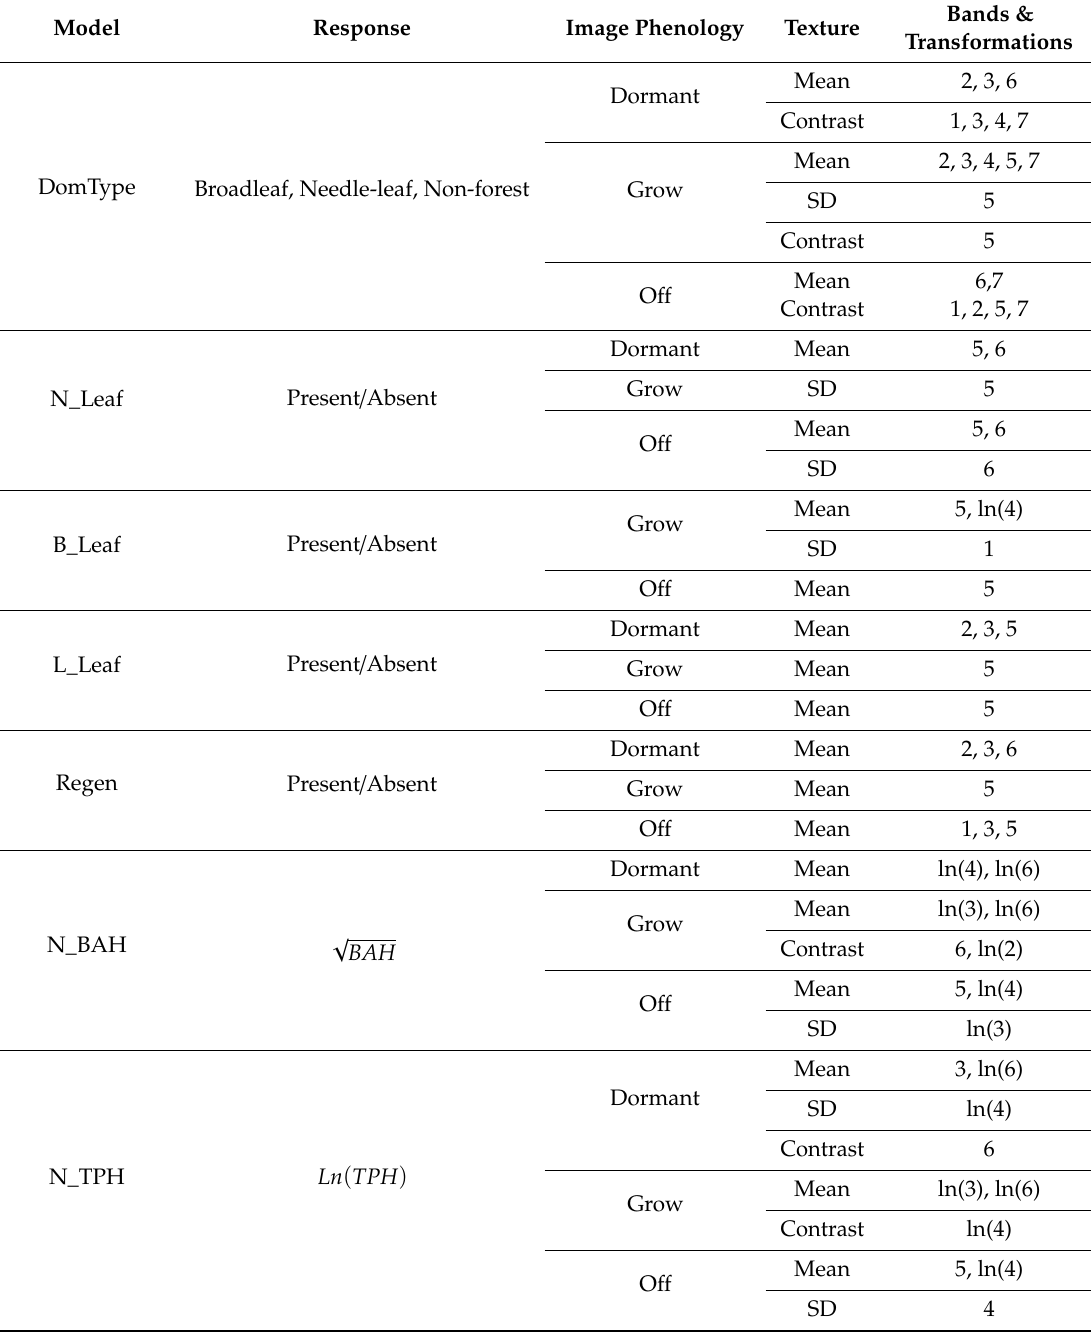
Table A4. Response and predictor variables selected in final L1 and L2 forest characteristics